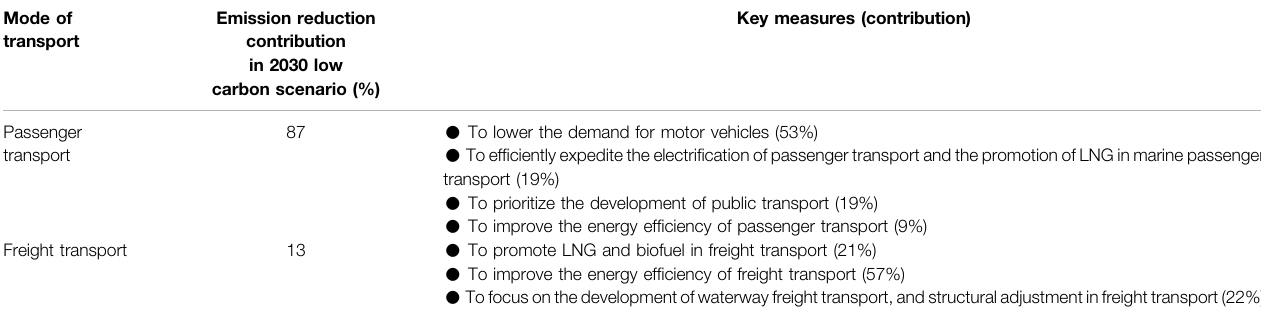
TABLE 3 | Conclusion of the essential policy implications on transportation in